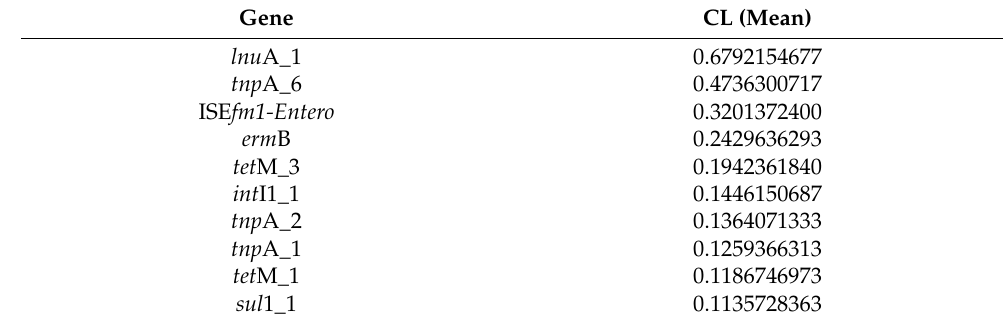
Figure 5. Relative abundance of the detected antibiotic-resistance gene groups, multi-drug re- sistance mechanisms, mobile genetic elements, integrase and transposase, visualized as gene copy number normalized per 16S rRNA gene copies. The visualization represents the mean value for three replicates.